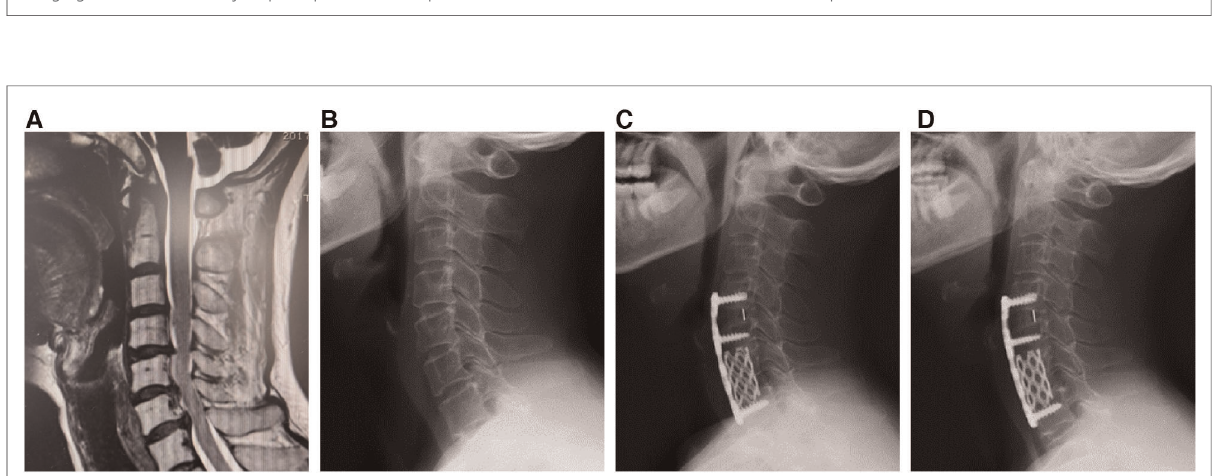
FIGURE 1 Male, 69-year-old, underwent three-level anterior cervical discectomy and fusion (ACDF) surgery. ( A ) The pre-operational magnetic resonance imaging (MRI), ( B ) the x-ray of pre-operation, ( C ) operation after 3 months, and ( D ) the fi nal follow-up.